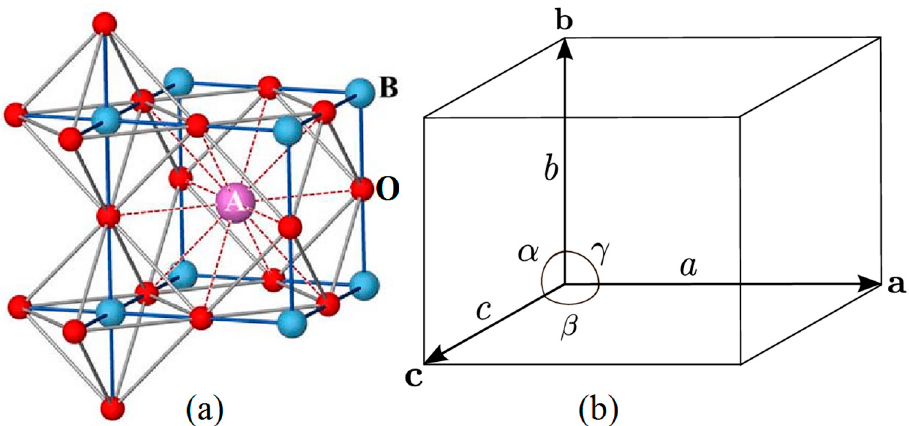
Figure 1. ( a ) ABO 3 -type ideal cubic perovskite structure, “adapted with permission from Ref. [15], Mineral. Mag. 2017 , 81 , 411–461, Mitchell, R.H.; Welch, M.D.; Chakhmouradian, A.R.” and ( b ) Cu- bic structure with lattice constants (a, b, c, α , β , γ )